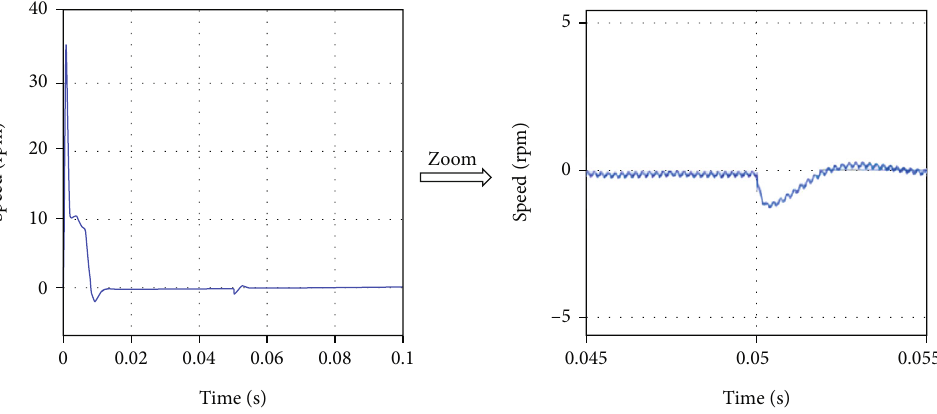
Figure 25: Speed estimation error using the 2021 LO.